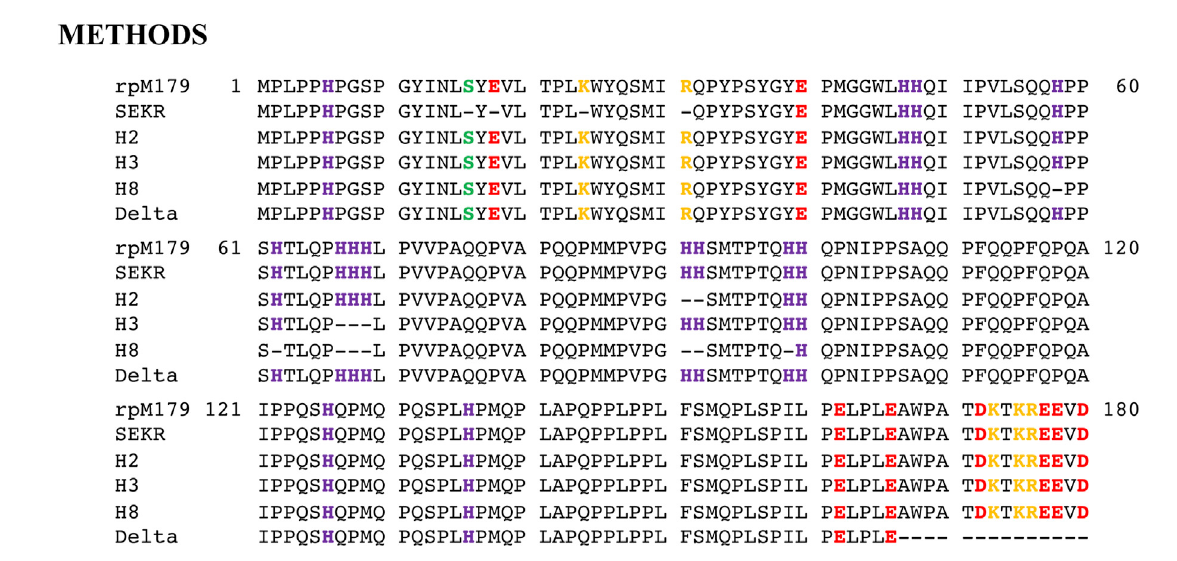
FIGURE 1 Primary amino acid sequences for rpM179 and the mechanistic probes SEKR, H2, H3, H8, and Delta. The amino acids that are removed from rpM179toformthemechanisticprobesareindicatedbydashes.SEKRisformedbytheremovalofS16,E18,K24,andR31intheN-terminus,H2bythe removal ofH91 and H92, H3 bythe removal ofH67, H68, and H69,H8 by theremovalof H58, H62,H67, H68, H69,H91, H92, and H99, and Delta by the removal of A167WPATDKTKREEVD180 in the C-terminus. Amino acids with side chains that are acidic, strongly basic, and weakly basic (histidines) are colored red, yellow, and purple, respectively. The serine at S16 that undergoes post translational phosphorylation is colored green. Note that the methionine at M1 is removed during the recombinant synthesis